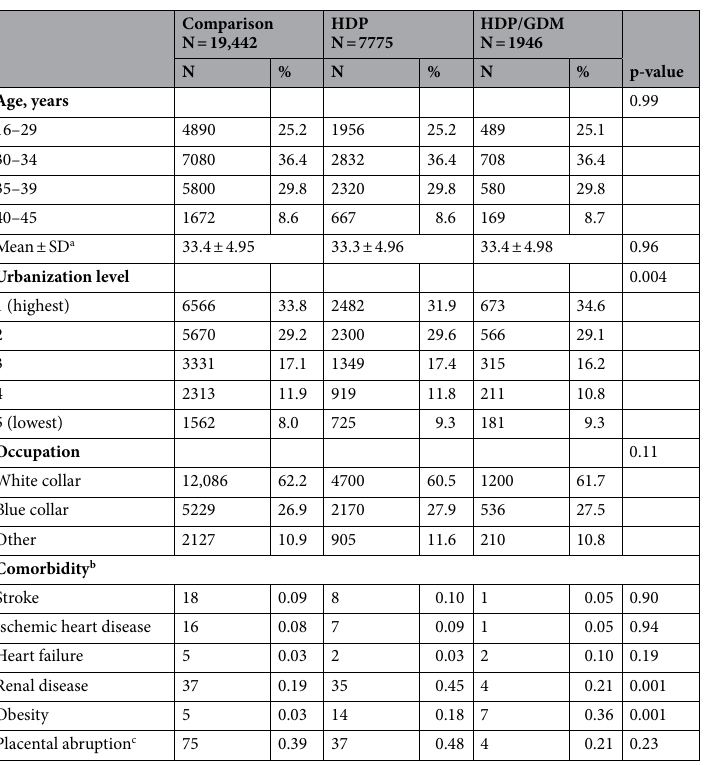
Table 1. Demographics and comorbidities in women with hypertension during pregnancy (HDP), women with HDP and gestational diabetes mellitus (GDM), and comparison group. Chi-square test used for categorical variables. a ANOVA test. b Baseline comorbidity using Fisher’s exact test. c Complication of present